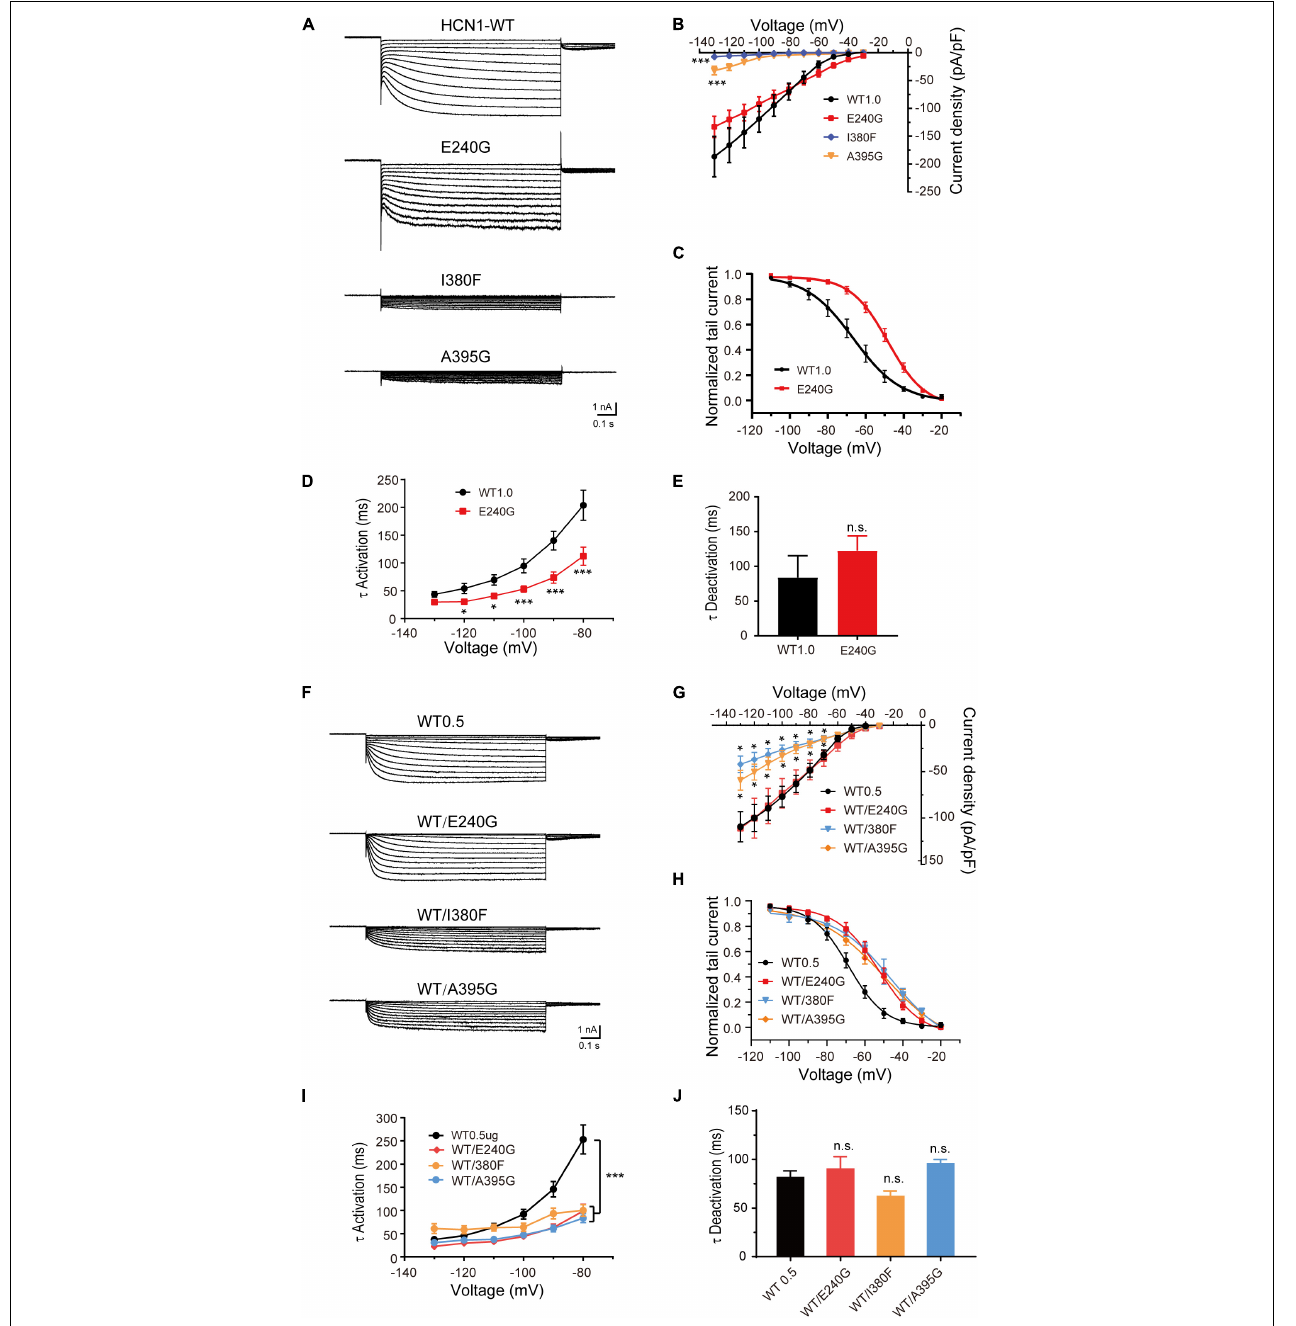
FIGURE 3 | Electrophysiological properties of novel and de novo variants in HCN1 located in or close to transmembrane regions. (A) Representative recordings of currents mediated by mutant HCN1 channels. (B) Current densities of E240G ( n = 16), I380F ( n = 9), and A395G channels ( n = 8) (WT1.0: n = 9). Dunnett’s T3 post hoc test. (C) Activation curves of WT and E240G channels (WT: n = 12; E240G: n = 11), and lines represent Boltzmann functions fit to the data points. (D) Mean time constants of activation obtained for HCN-WT (black) and E240G channels (red). (WT: n = 8; E240G: n = 15). Dunnett’s T3 post hoc test. (E) Bar graph shows mean deactivation time constants of WT and E240G channels recorded at + 10 mV (WT: n = 8; E240G: n = 12). Two-sample t -test. (F) Representative traces of heterozygous channels. (G) Plot of mean current densities of WT/E240G ( n = 13), WT/I380F ( n = 13), WT/A395G ( n = 12), and WT channels ( n = 18). Dunnett’s T3 post hoc test. (H) Activation curves of WT channels ( n = 6, black), WT/I380F channels ( n = 6, blue), WT/E240G ( n = 11, red), and WT/A395G channels ( n = 12, orange). Bonferroni post hoc test. (I,J) Graphs show the effects of the activation (WT/E240G: n = 17; WT/I380F: n = 12; WT/A395G: n = 19; WT0.5: n = 12) and deactivation time constants (WT/I380F: n = 12; WT/E240G: n = 17; WT/A395G n = 17; WT0.5 n = 14) induced by mutant heterozygous channels. Bonferroni post hoc test. All data are presented as mean ± S.E.M. values (n.s. = not significant, * P < 0.05, *** P < 0.005, in this and other figures).